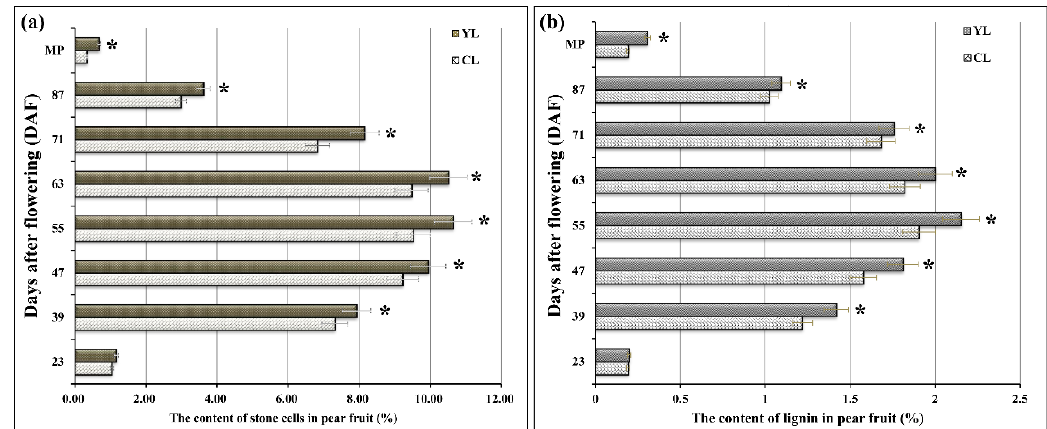
Figure 1. Differences in stone cell and lignin content of pear fruit obtained from two pollination combinations: ( a ) The content of stone cells in YL and CL fruits; ( b ) The content of lignin in YL and CL fruits. YL: ‘Yali’ ♂ × ‘ Lianglizaosu ’ ♀ ; CL: ‘Cuiguan’ ♂ × ‘ Lianglizaosu ’ ♀ . Student’s t test was used for the statistical analyses. Four fruits were selected for analysis at each period. * indicates a significant difference ( p < 0.05).